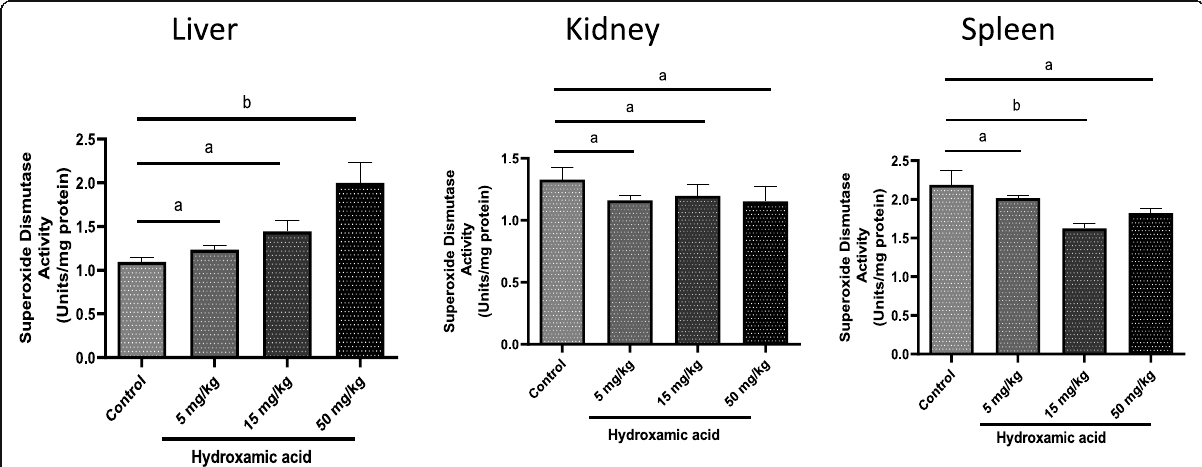
Fig. 1 Superoxide dismutase activity in liver, kidney, and spleen. Values are expressed as mean ± SEM; ( n = 5). Different letters indicate significant difference at p < 0.05